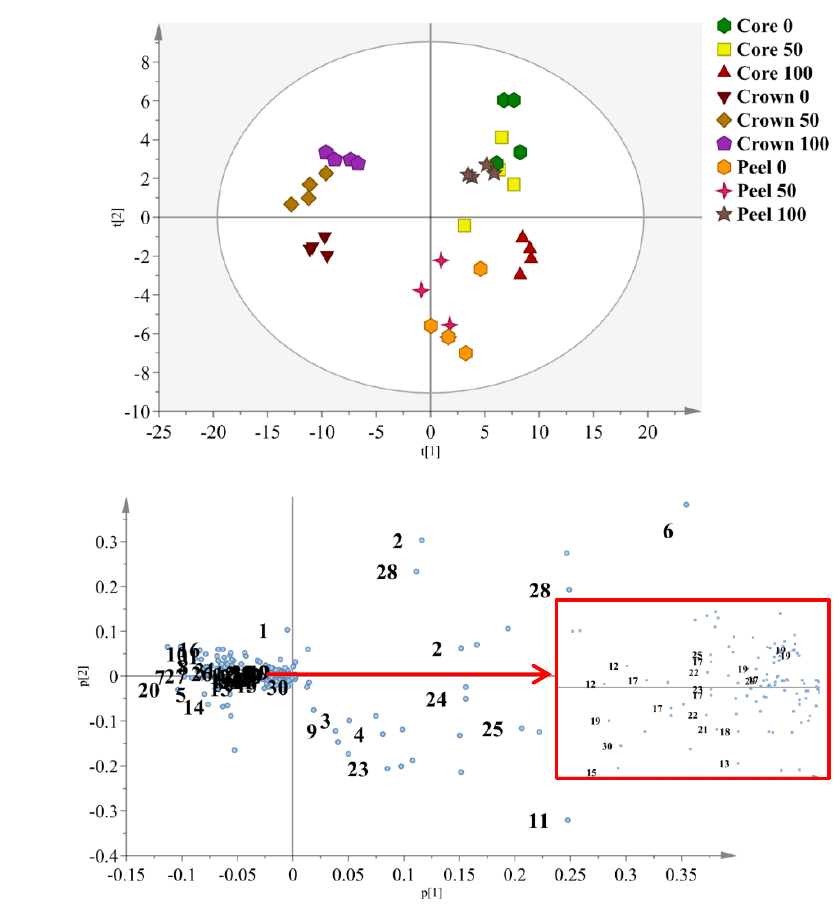
Figure 3. ( a ) The PCA score plot for MD2 pineapple peel, crown and core extracted with 0, 50 and 100% ethanol ratio. ( b ) The PCA loading plot. See Table 1 for the assignments of metabolites.